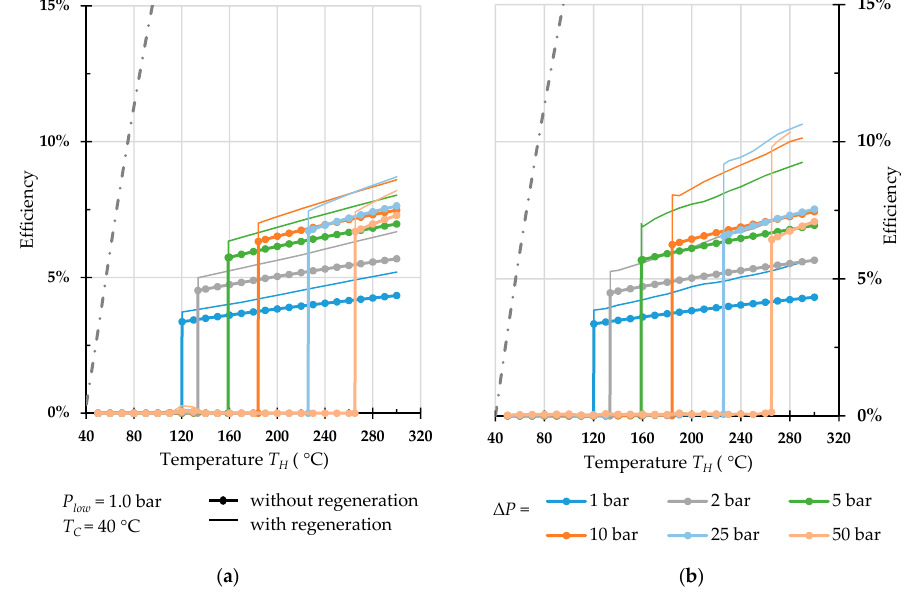
Figure 8. Efficiency of regenerative Worthington-type machine ( a ) and Bush-type machine ( b ) operated with water.